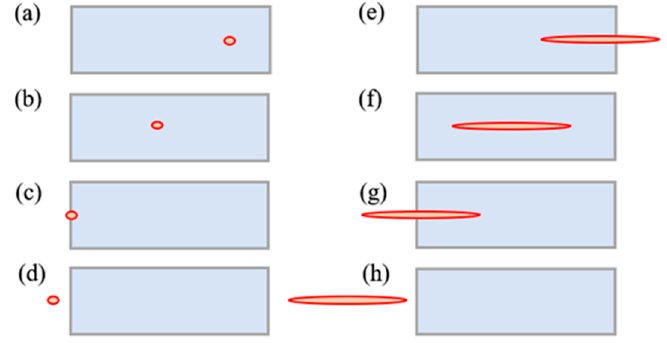
Figure 4. Spatial relationship between the focal region of ( a – d ) LG, ( e – h ) BG beams and cuvette. The red areas denote the focal region, and light blue rectangles denote the cuvette filled with water.